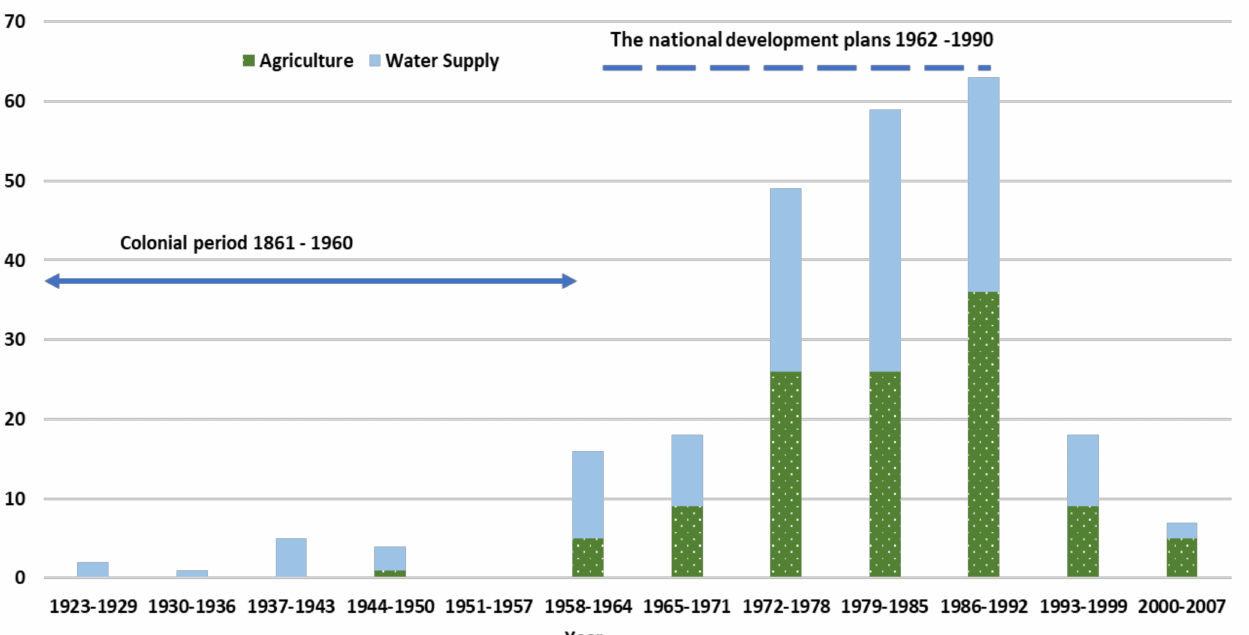
Figure 3. Distribution and trend of dams constructed for water supply and agriculture from 1923–2007 in Nigeria